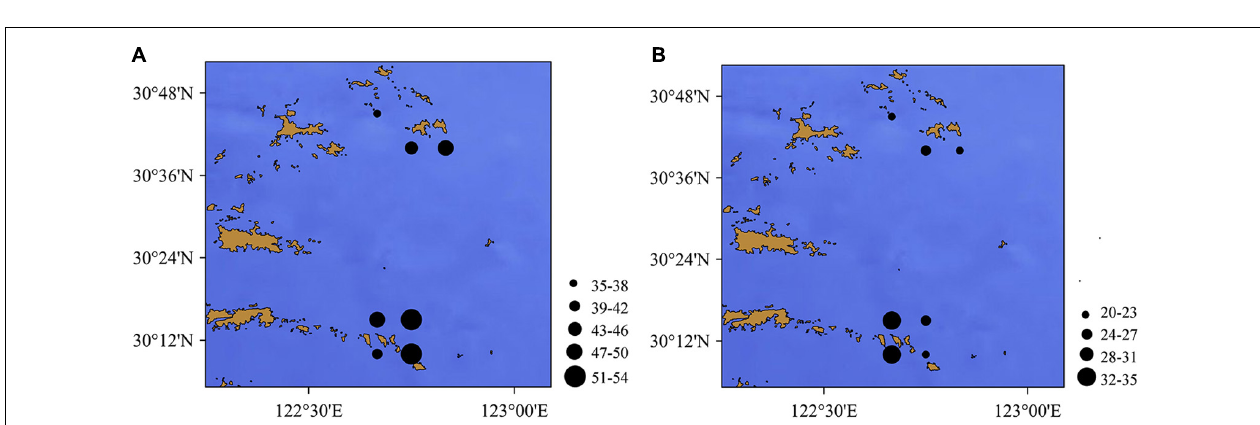
by H. nehereus (7.9%) and Argyrosomus argentatus (5.7%) ( Figure 6A ). However, the species with the highest number of fish according to eDNA metabarcoding was Poecilopsetta plinthus (57.4%), followed by Miichthys miiuy (12.1%), and Chanos chanos (6.9%), with Poecilopsetta plinthus accounting for more than half of the fish diversity. In winter, 1,856 fish were caught